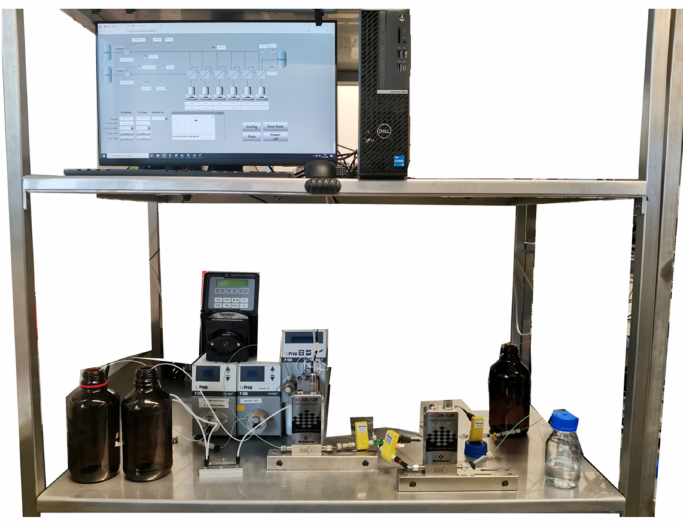
Figure 26. Set-up of the mixing section for the LNP